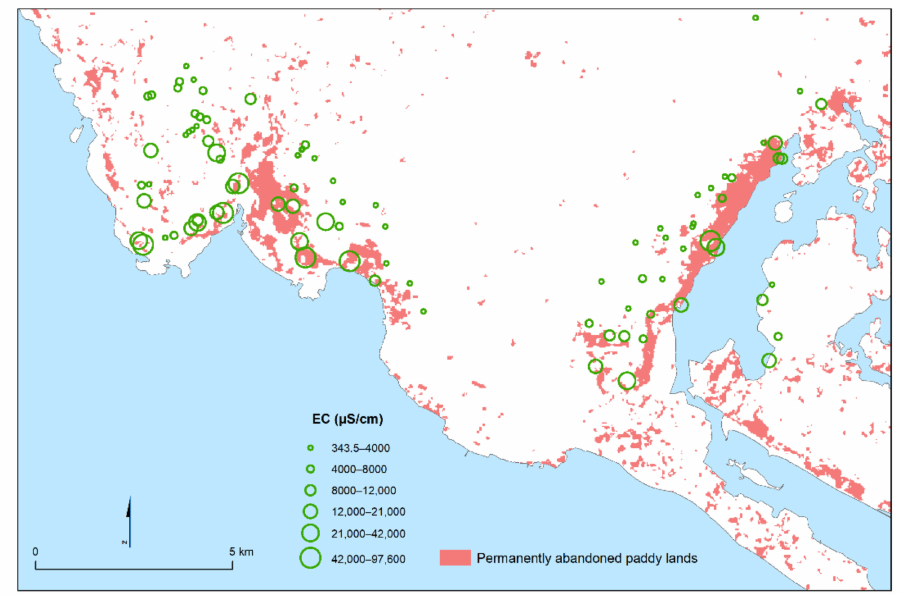
Figure 8. Groundwater salinity levels in selected wells overlaid on the permanently abandoned paddy lands for 2019 in Jaffna Peninsula. Adapted from Gopalakrishnan, Kumar and Mikunthan